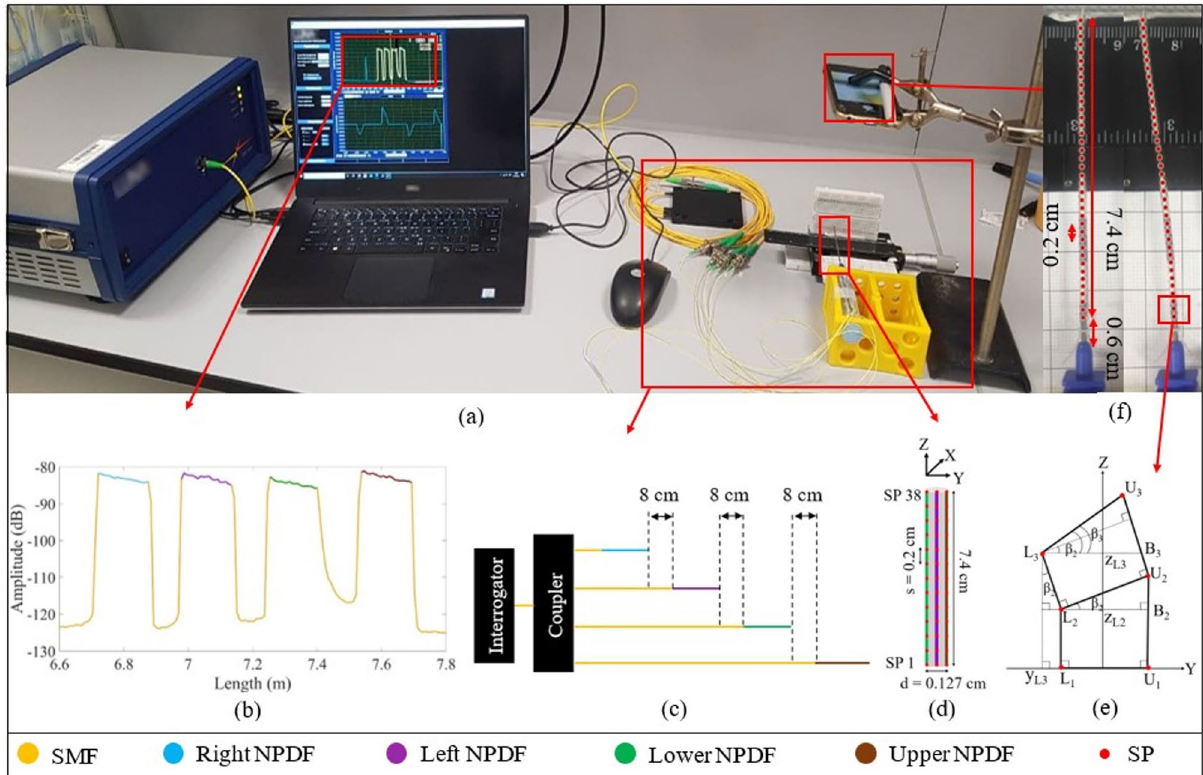
Figure 7. Experimental setup: ( a ) The photo of the setup consisting of the Luna OBR interrogator with the evaluation software, 1 by 4 coupler connecting the interrogator output to the four SMFs of different lengths spliced with NPDFs, the epidural needle equipped with four NPDFs and held by the yellow fixation box, the micropositioner which moves the tip of the needle from 0 to 1 cm with a 0.1 cm step, the phone which takes photos of the needle position in order to reconstruct the real shape of the needle using the online program; ( b ) backscattering spectrum of four NPDFs spliced with SMFs detected by the interrogator; ( c ) the schematics of the multiplexing of the NPDFs; ( d ) The schematics of the NPDFs arrangement on the needle; ( e ) The schematics of needle during bending to the lower direction (first three SP levels); ( f ) examples of the needle positions photos after the processing with the online program. The program gives the coordinates of the sensing points (red dots) along the